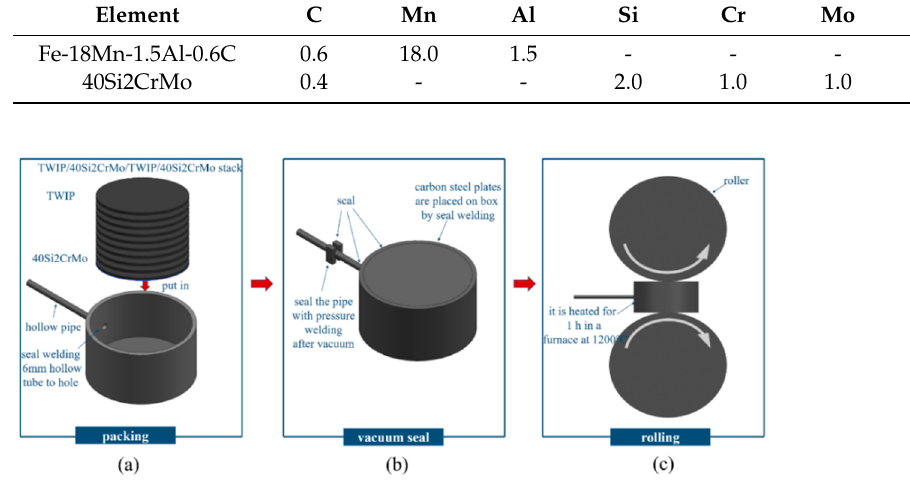
Figure 2. The fabricated process of hot rolled multilayer TWIP/40Si2CrMo steel: ( a ) packing billet; ( b ) vacuum sealing; ( c ) hot rolling.